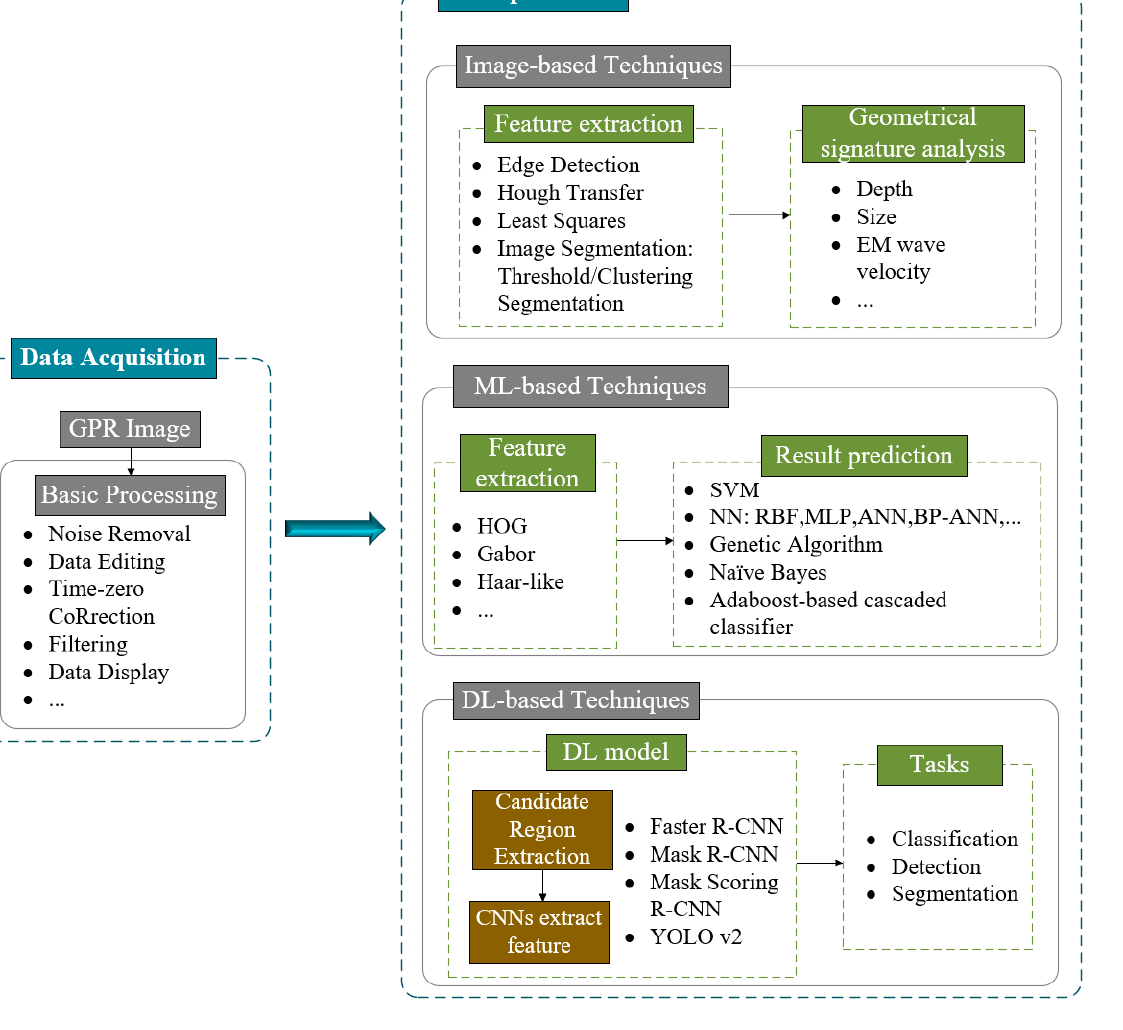
Figure 3. The diagram of target interpretation from GPR B-scans.